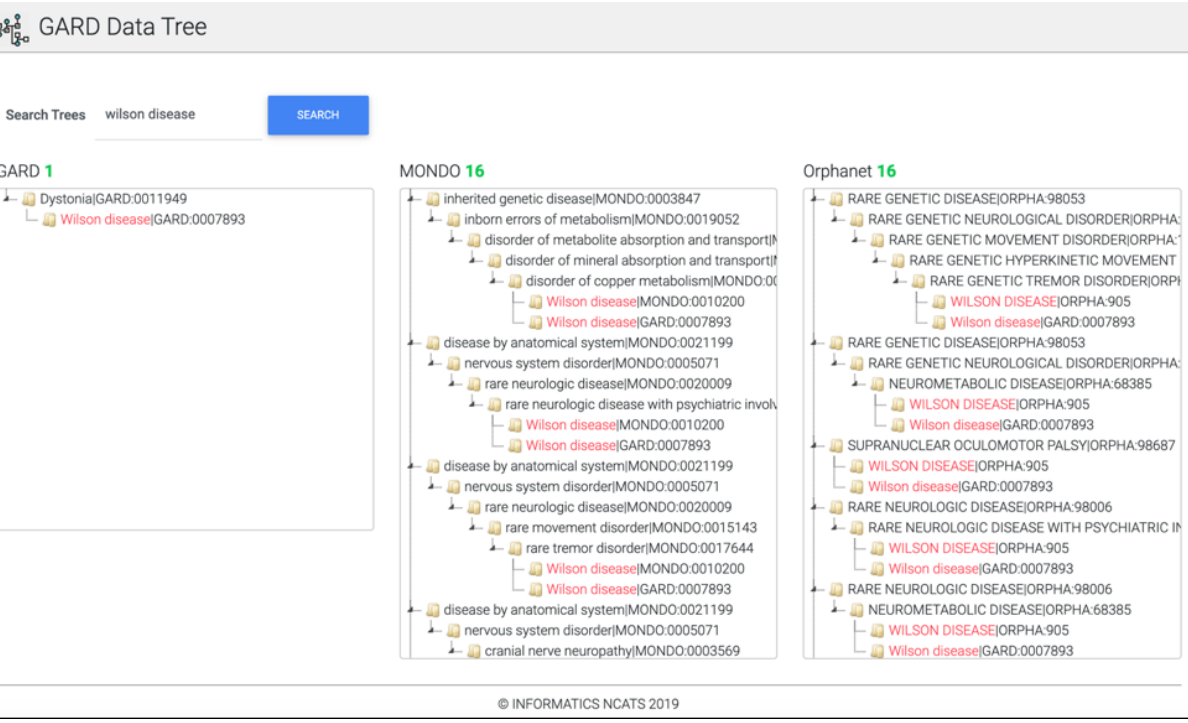
Figure 2. Disease tree visualization via the GARD Data Tree web